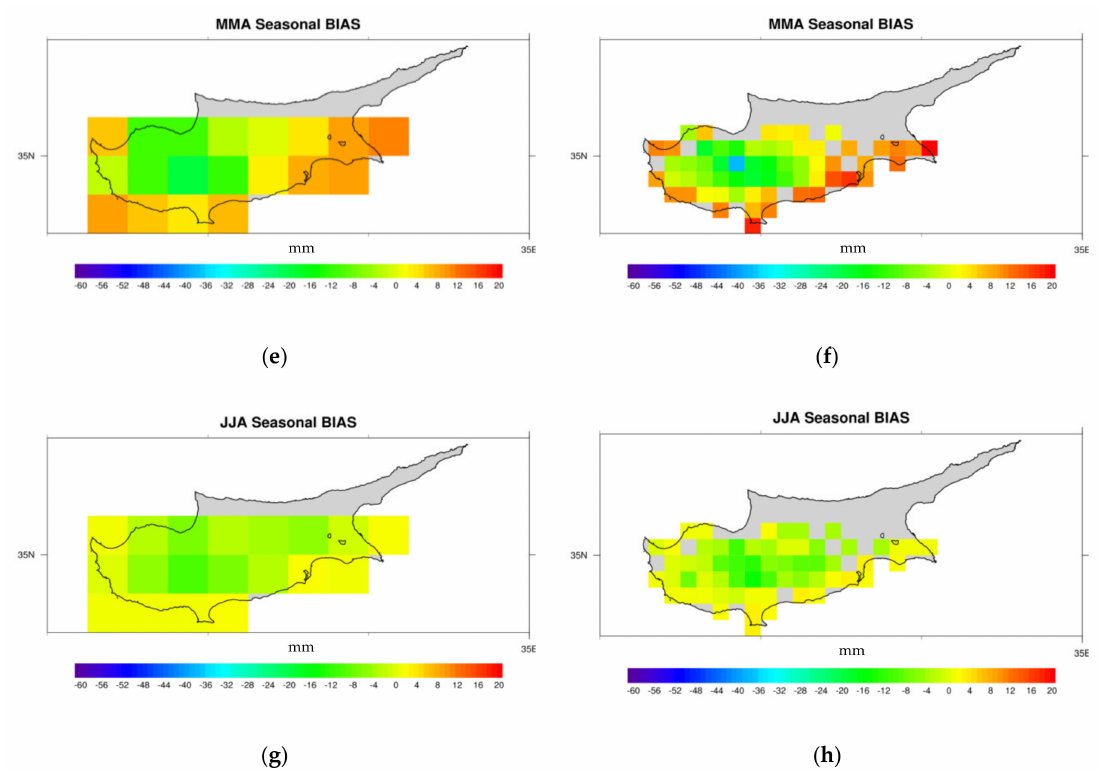
Figure 10. Seasonal bias for both precipitation products for the study period: ( a ) TRMM for September, October and November; ( b ) GPM for September, October and November; ( c ) TRMM for